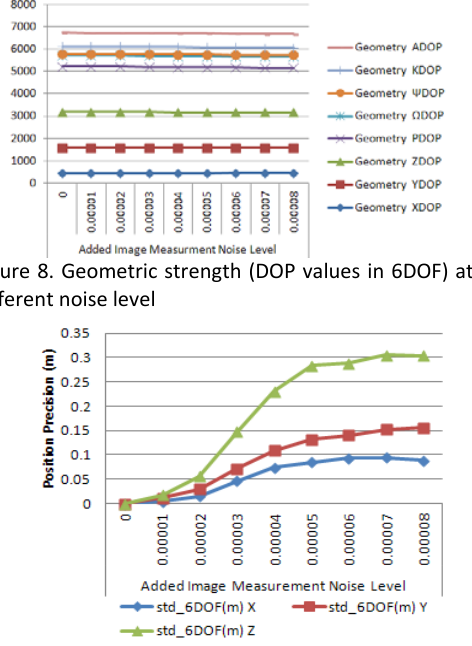
Figure 9. Variation of position precision at different image measurement noise level